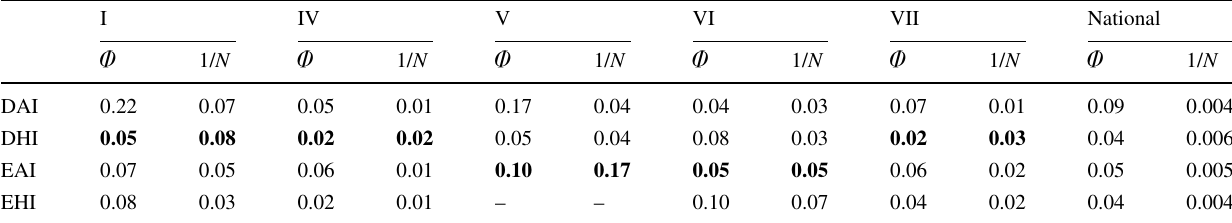
Table 4 Effectiveness of risk pooling in each agricultural zone for rice